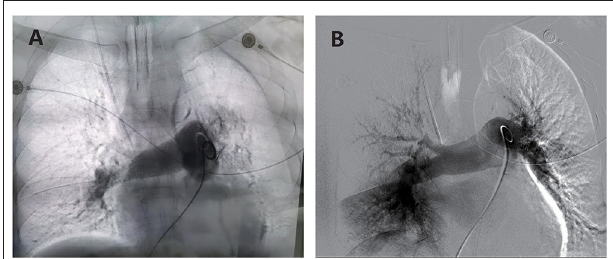
FIGURE 3 | (A) Angiography demonstrating extensive thrombus in bilateral pulmonary arteries with compromised blood flow. (B) Angiography post-thrombectomy demonstrates decreased clot burden and improved flow in both pulmonary arteries.